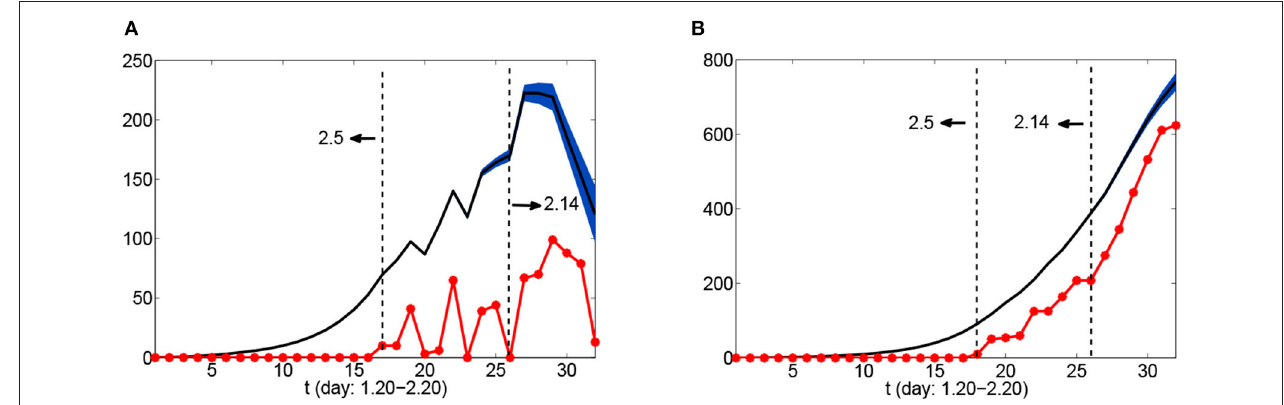
FIGURE 4 | Number of infected people as a function of time from January 20 to February 20 in Case II: (A) daily new number of infected cases; (B) daily cumulative number of infected cases. Red dots represent actual confirmed numbers; black dotted lines indicate critical time nodes; the black solid line represents the theoretical mean value of the number of infected, λ C ( t )( N − G ( t ) − I ( t )) N − G ( t )